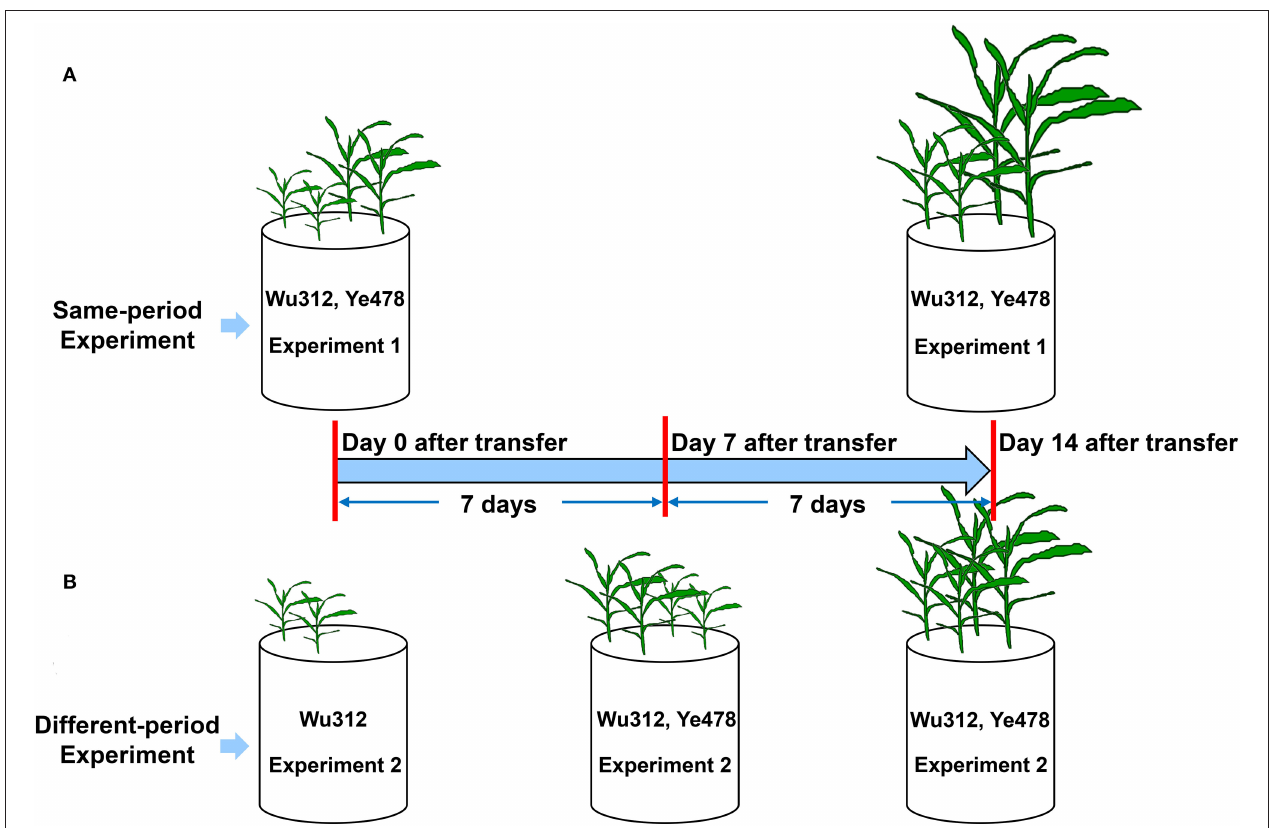
FIGURE 1 | Experimental setup in Experiments 1 and 2. (A) In Experiment 1, two seedlings of Fe-inefficient inbred line Wu312 and Fe-efficient inbred line Ye478 were simultaneously grown in hydroponics for 14 days. (B) In Experiment 2, only two seedlings of Wu312 were transferred at the same time with Experiment 1, and then, two seedlings of Ye478 were transferred 7 days